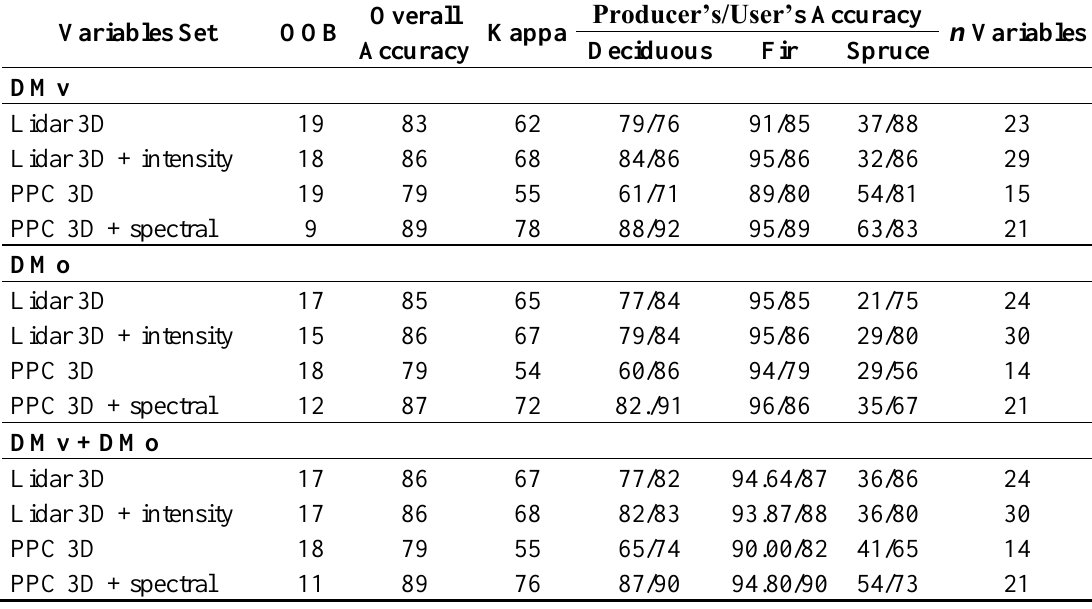
Figure 10. Scatterplots of the lidar and PPC-based tree crown areas (red line represents the slope of the relationships and dashed line represents the 1:1 relationship). Table 7. Species classification results from lidar and PPC